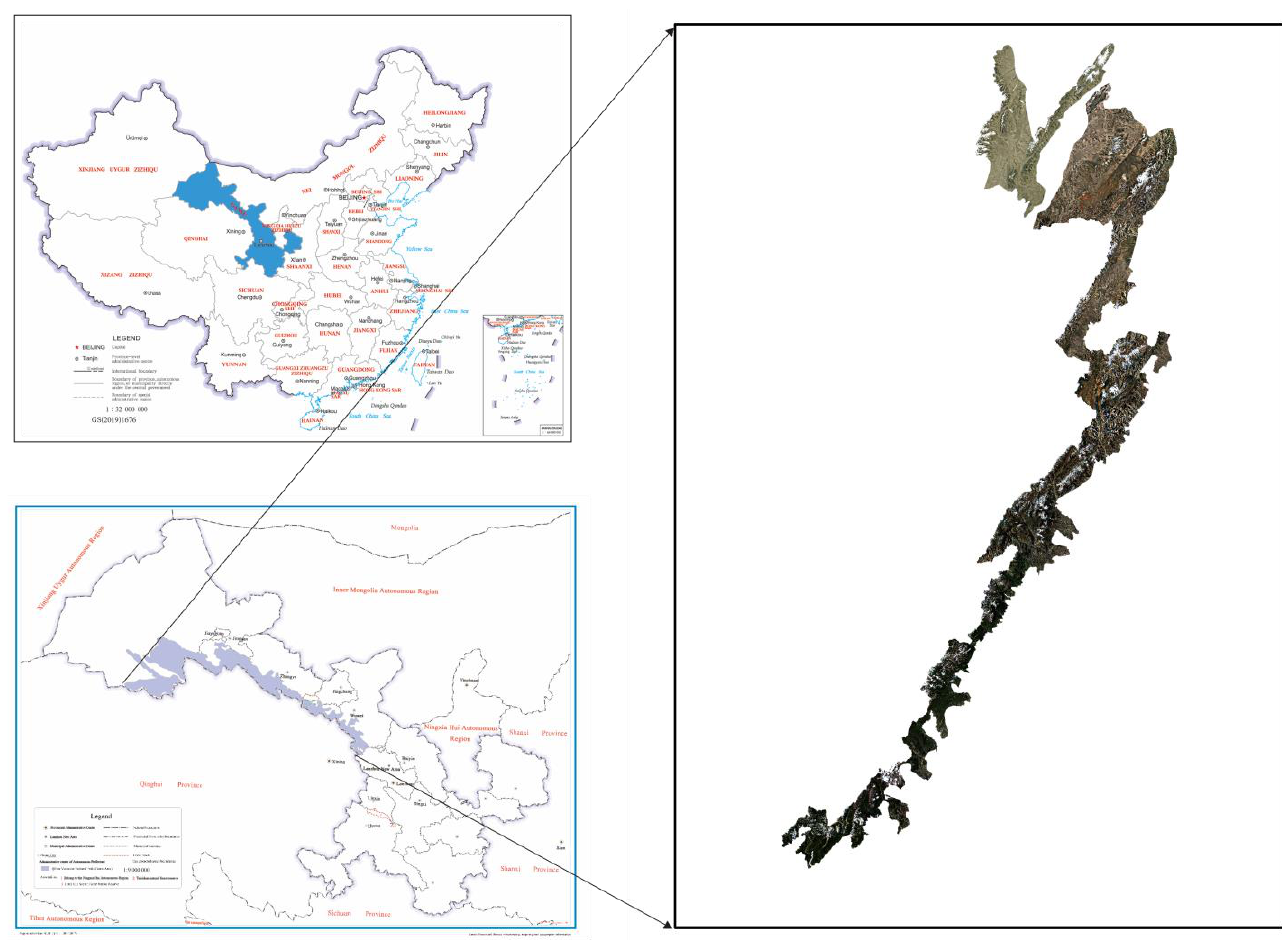
Figure 1. Location of the study area.